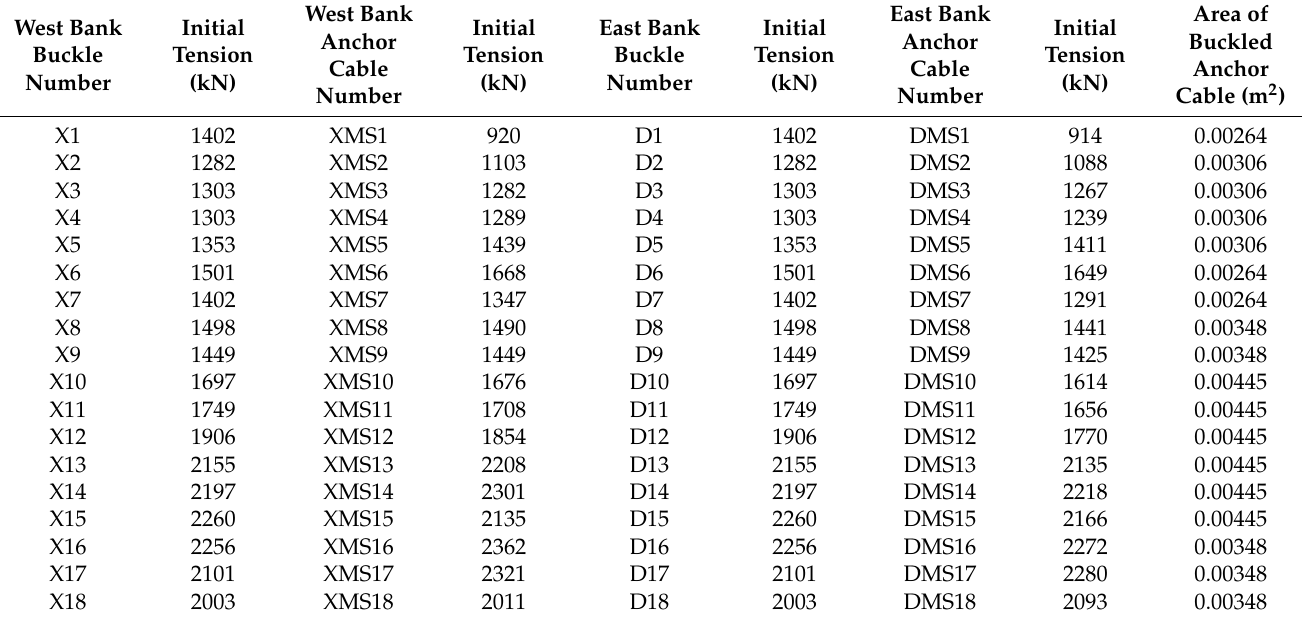
Table 6. The initial tension and area of the anchor